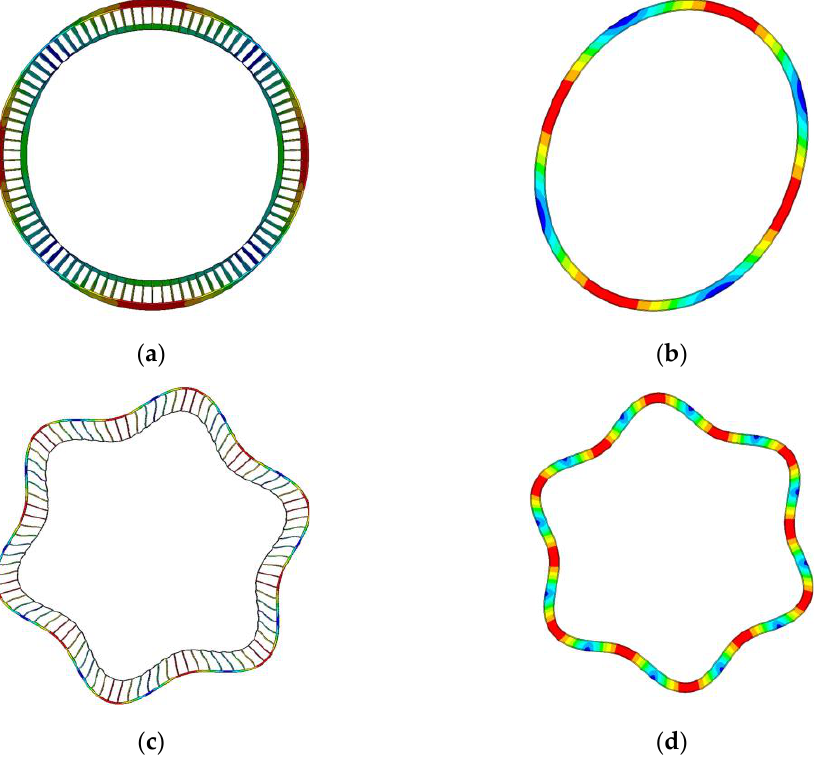
Figure 14. Shapes of ( a ) 2nd and ( c ) 6th nodal diameter modes of the stator, ( b ) 2nd and ( d ) 6th nodal diameter modes of the physical replacement with the box cross-section.